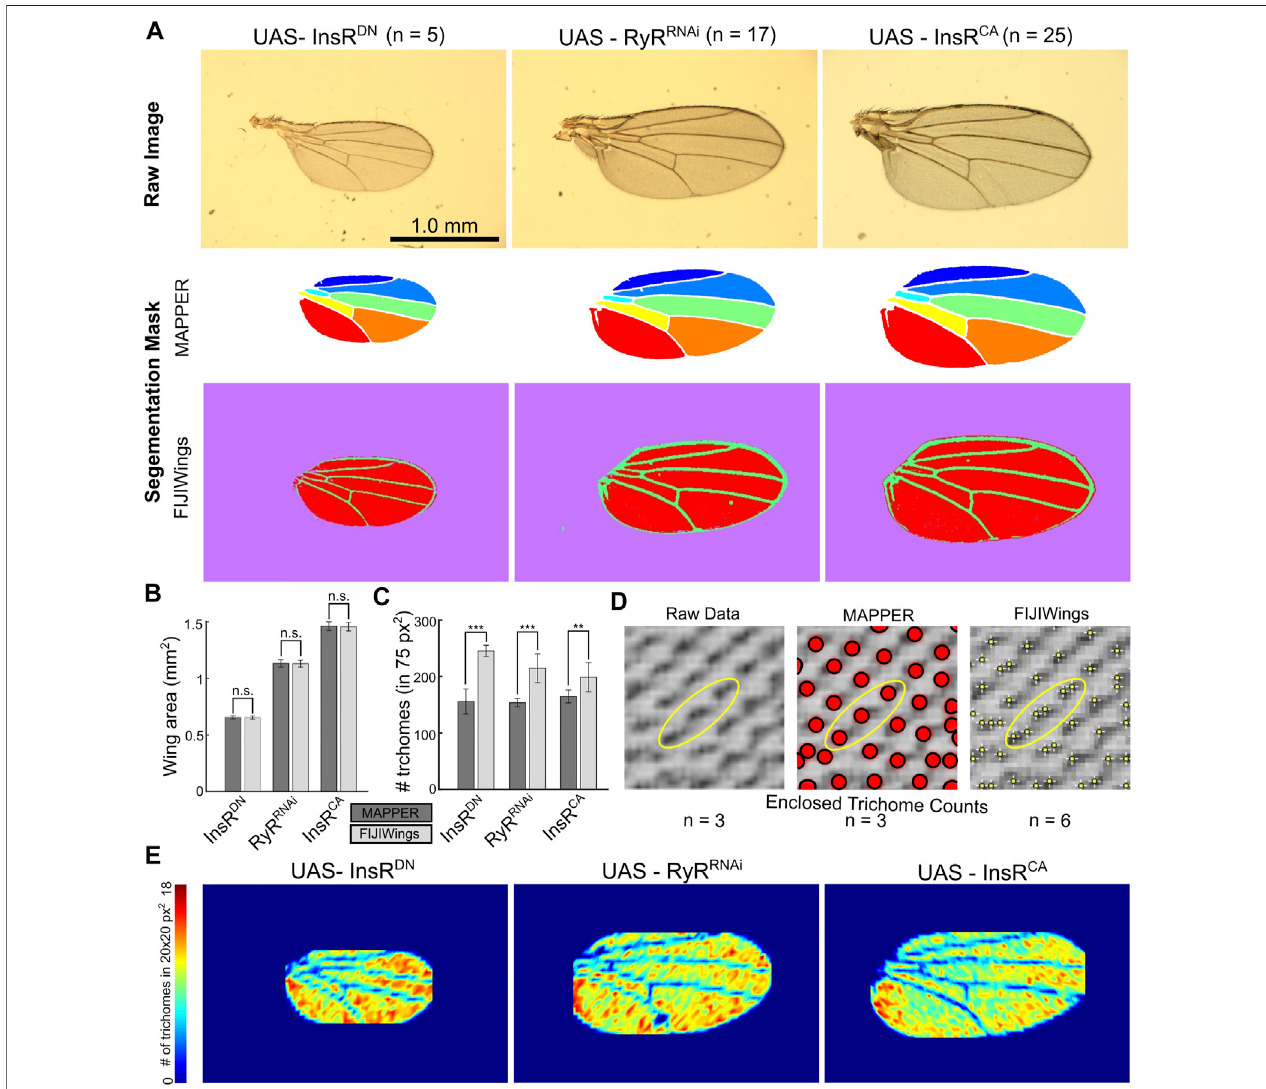
FIGURE4 | MAPPER provides precise segmentation and extraction of wingshape and trichome density. (A) MAPPER automates identi fi cation and labeling of the individual intervein components with high accuracy. InsR DN is the dominant negative form of the insulin receptor, and InsR CA is the constitutively active insulin receptor. RyR RNAi is the GAL4-UAS knockdown of the ryanodine receptor, which is not known to be expressed in the wing disc. Full genotypes are the Nubbin-Gal4, UAS- Gcamp6flines crossedtoeach oftheindicatedUAS lines. (B,C) Comparison ofwingareaand number oftrichomesina75×75pixel 2 bounding box, respectively, ascalculatedbyMAPPERandFIJIWings.Errorbarsindicatestandarddeviationinmeasurements.Statisticalcomparisonsforwingareawereperformedviatheunpaired T-testandF-test( p > 0.05,n.s.).StatisticalcomparisonsfortrichomecountswereperformedviatheMann-WhitneyUTest(MannandWhitney,1947;Nachar,2008)for nonparametriccomparisons( p < 0.001***, p < 0.01**). (D) ComparisonoftrichomelocationestimationbetweenMAPPERandFIJIWingswithrespecttotherawimage. (E) Heatmaps representing trichome density. The wing is binned into regions of 20 × 20 pixel 2 areas. Number of trichomes are calculated using MAPPER in wing